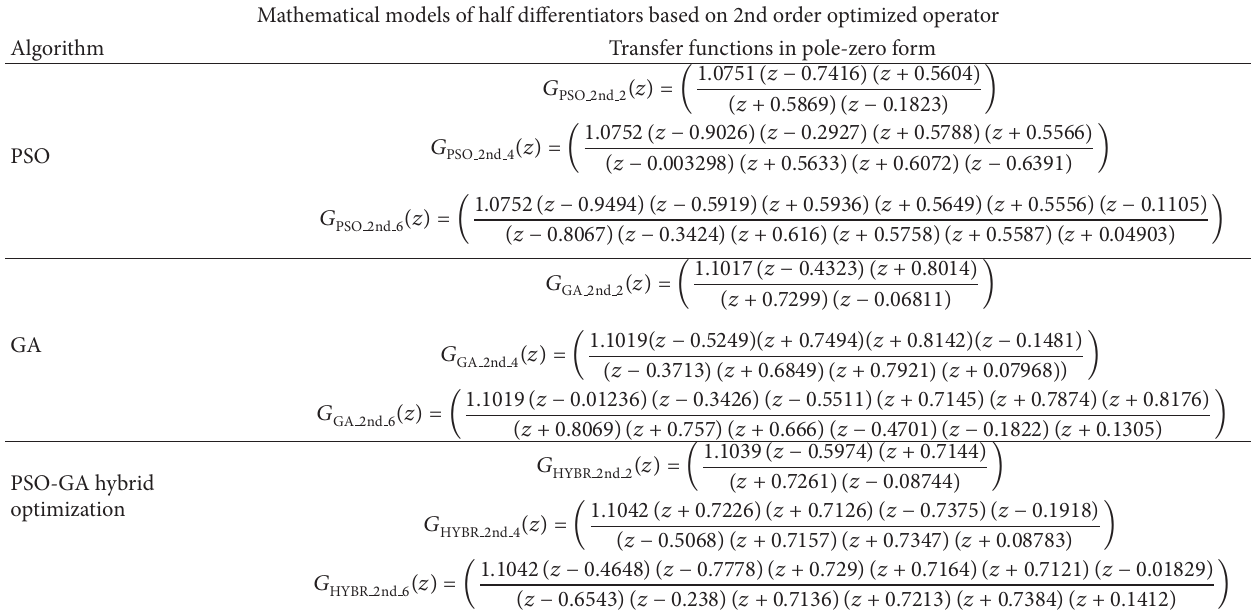
Table 2: Mathematical models of half differentiators based on 2nd order optimized operators. Algorithm Transfer functions in pole-zero